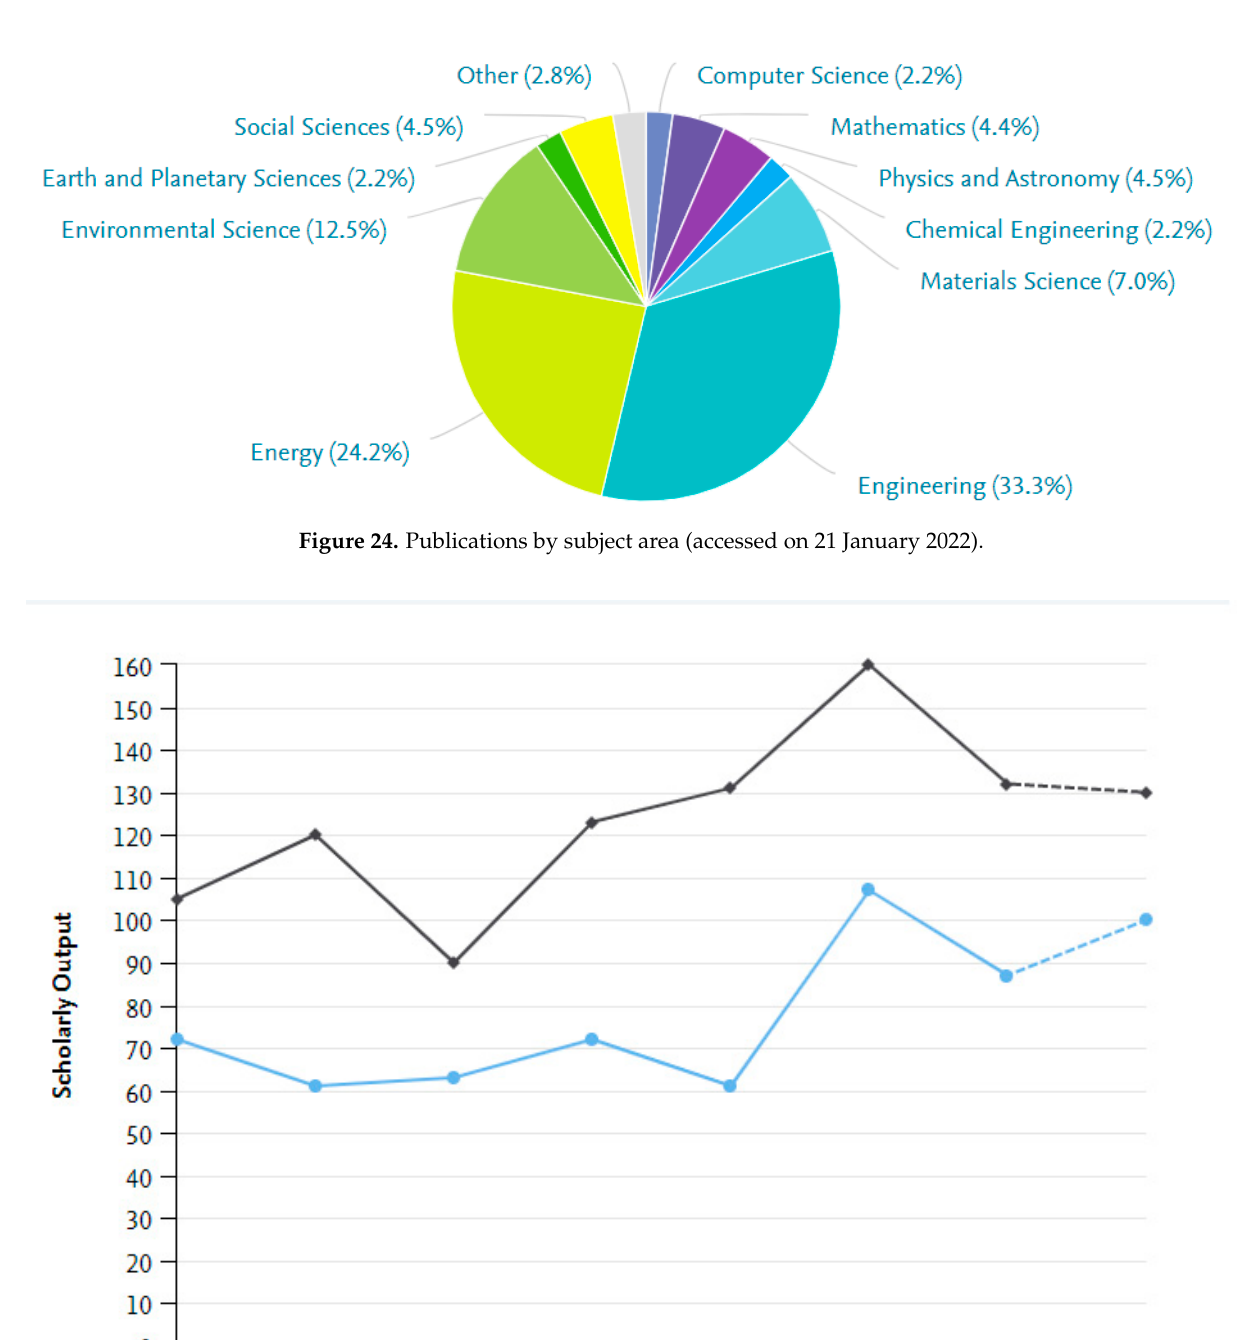
Figure 25. Benchmarking the publication year and scholarly output (accessed on 21 January 2022).